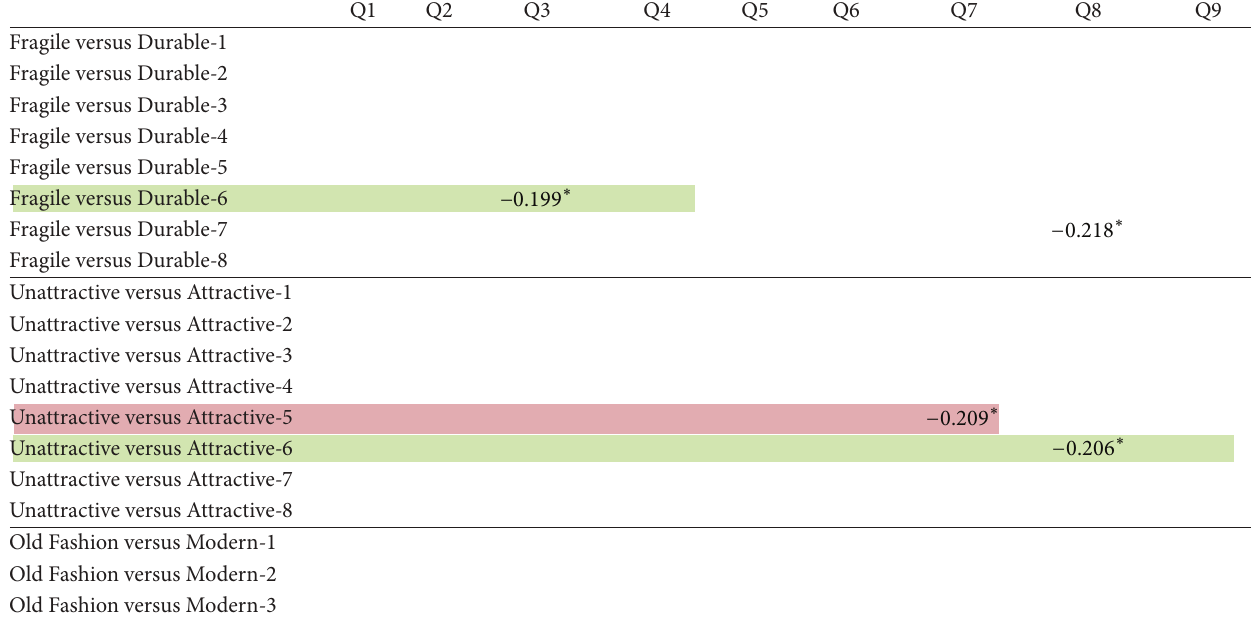
Table 14: The correlation between cognitive alert style and Kansei words based on the 8 designs